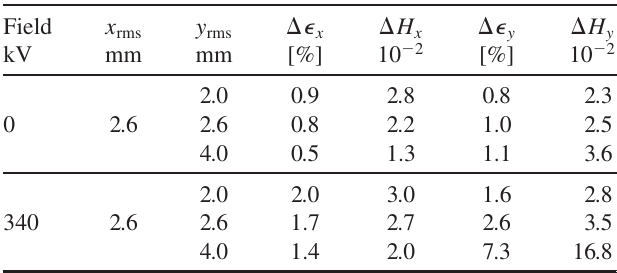
TABLE VIII. Aspect